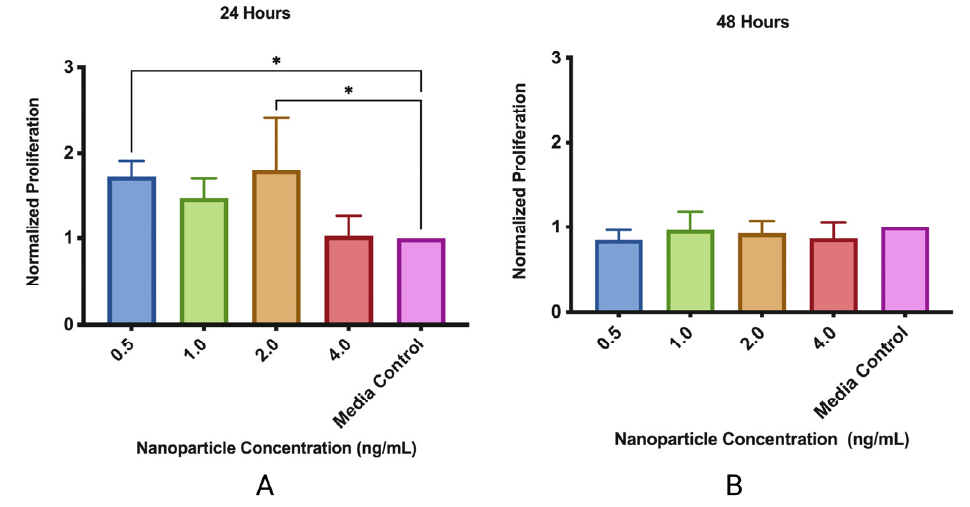
Figure 6. MMSC ECM nanoparticles are biocompatible. ( A ) MMSC ECM nanoparticles were added with MLE-12 cells for 24 h to test proliferative e ff ects; ( B ) MMSC ECM nanoparticles were added to MLE-12 cells for 48 h to test cytotoxicity. Data displayed is the mean ± standard deviation. * indicates p < 0.05. N = 3.